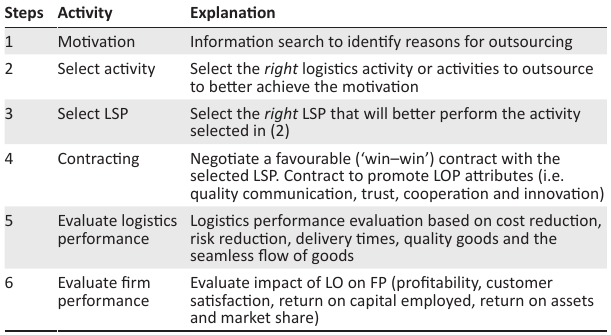
TABLE 5: Deduced process of logistics outsourcing.